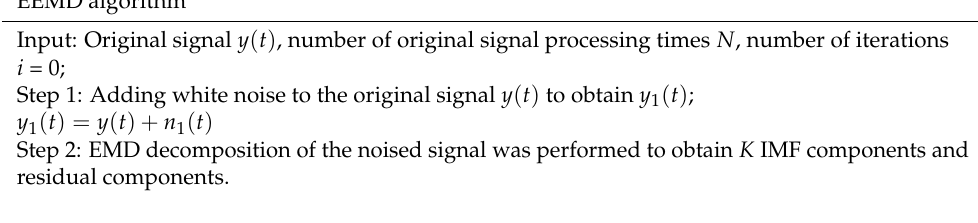
Table 2. EEMD decomposition process. EEMD